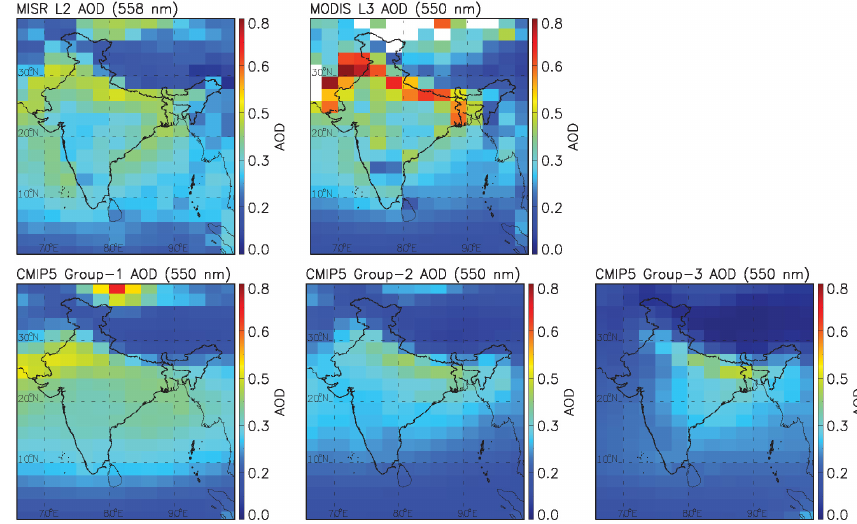
Figure 1. AOD climatology for 2000–2005 derived from MISR, MODIS, and the three model groups defined in the text.